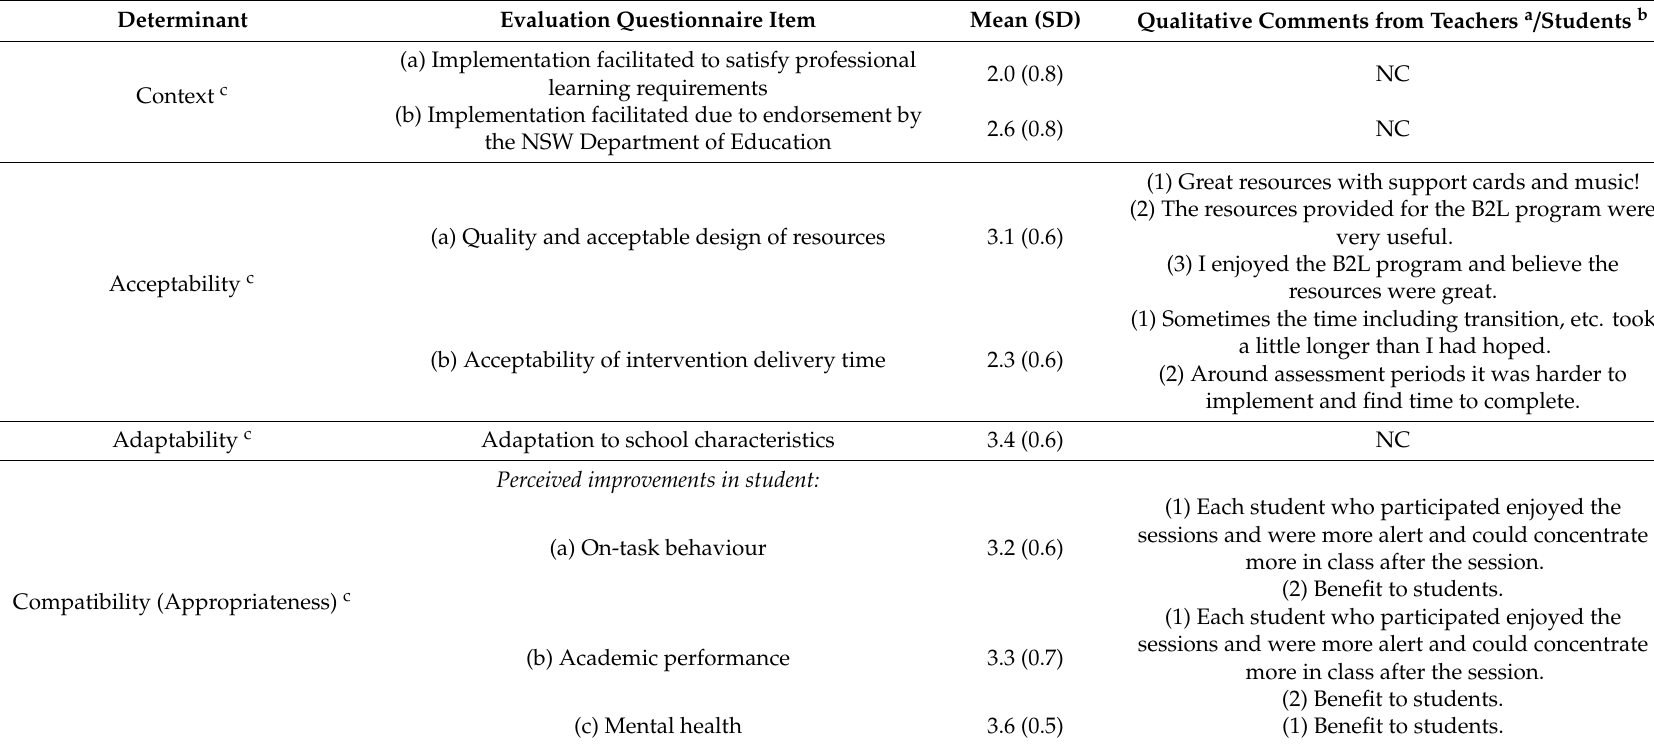
Table 4. Means of, and qualitative findings for, the included implementation